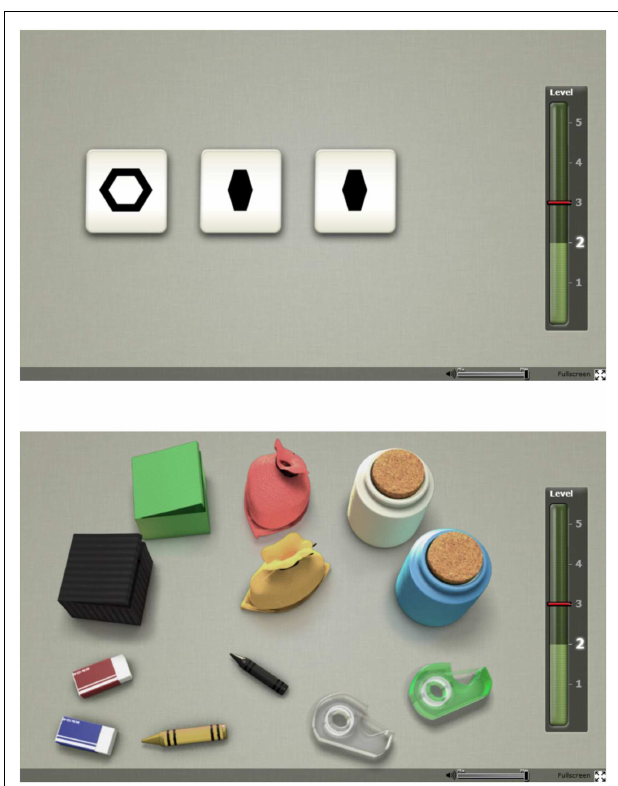
FIGURE 1 | Screen images of the online working memory tasks: Odd One Out (top) and Following Instructions (bottom)